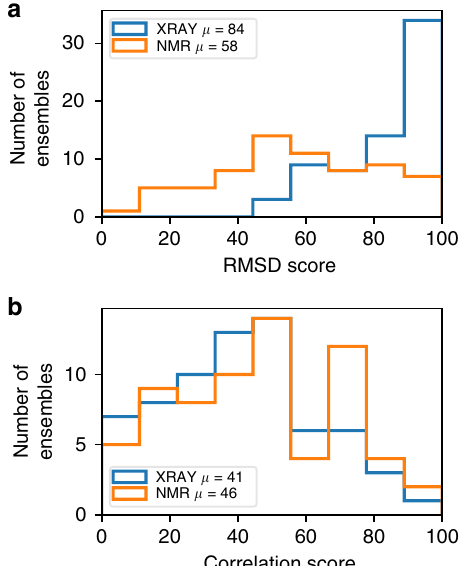
Fig. 6 Frequency distributions for X-ray structures (blue) and NMR ensembles (orange) as a function of ANSURR scores. a RMSD score and b correlation score. The mean values for each score are shown in the inset